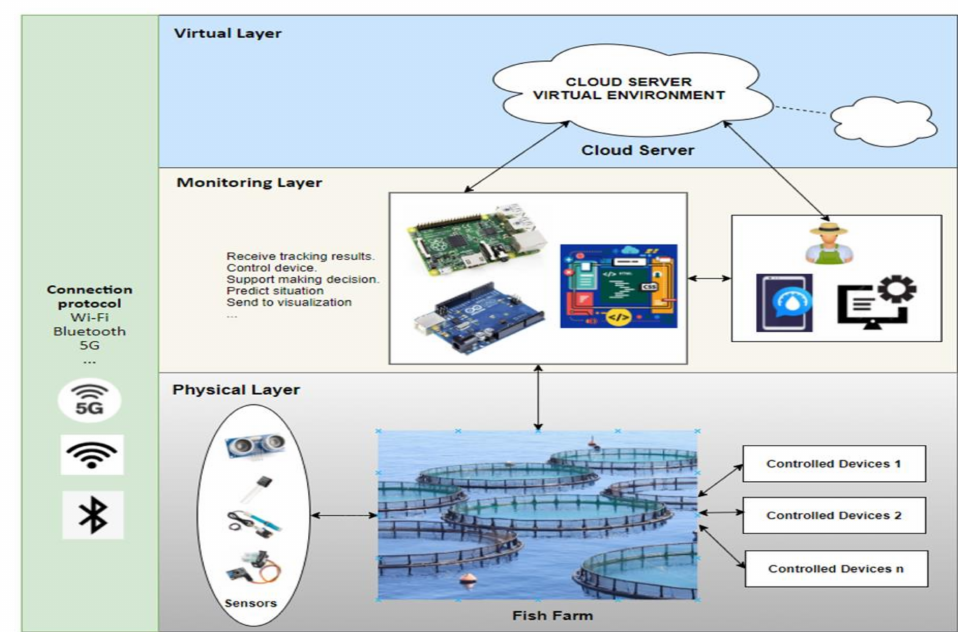
Figure 3. Internet of Things (IoT) Aquaculture